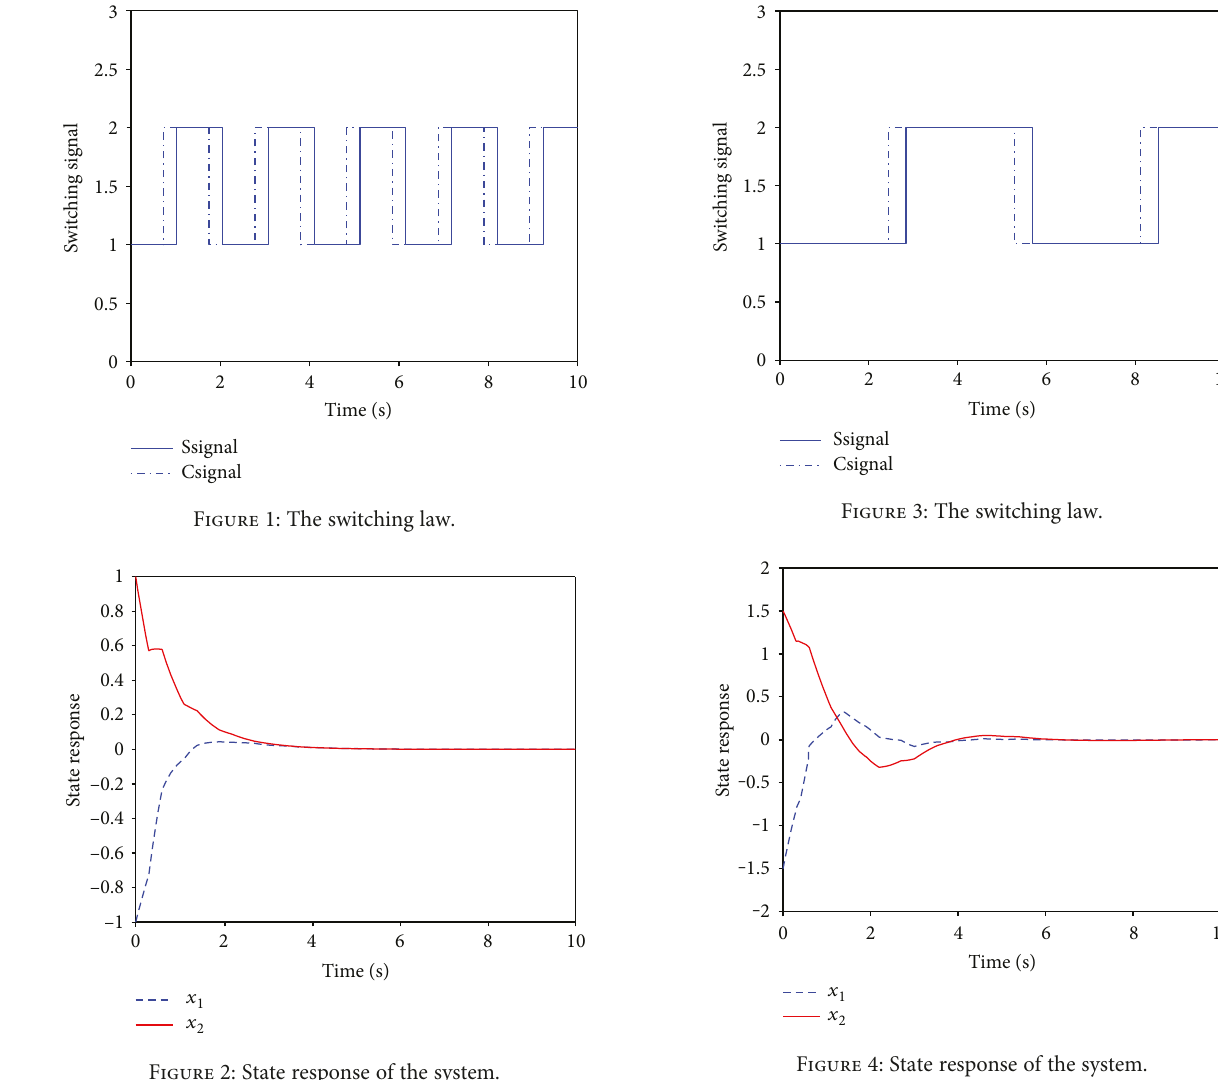
Figure 2: State response of the system.